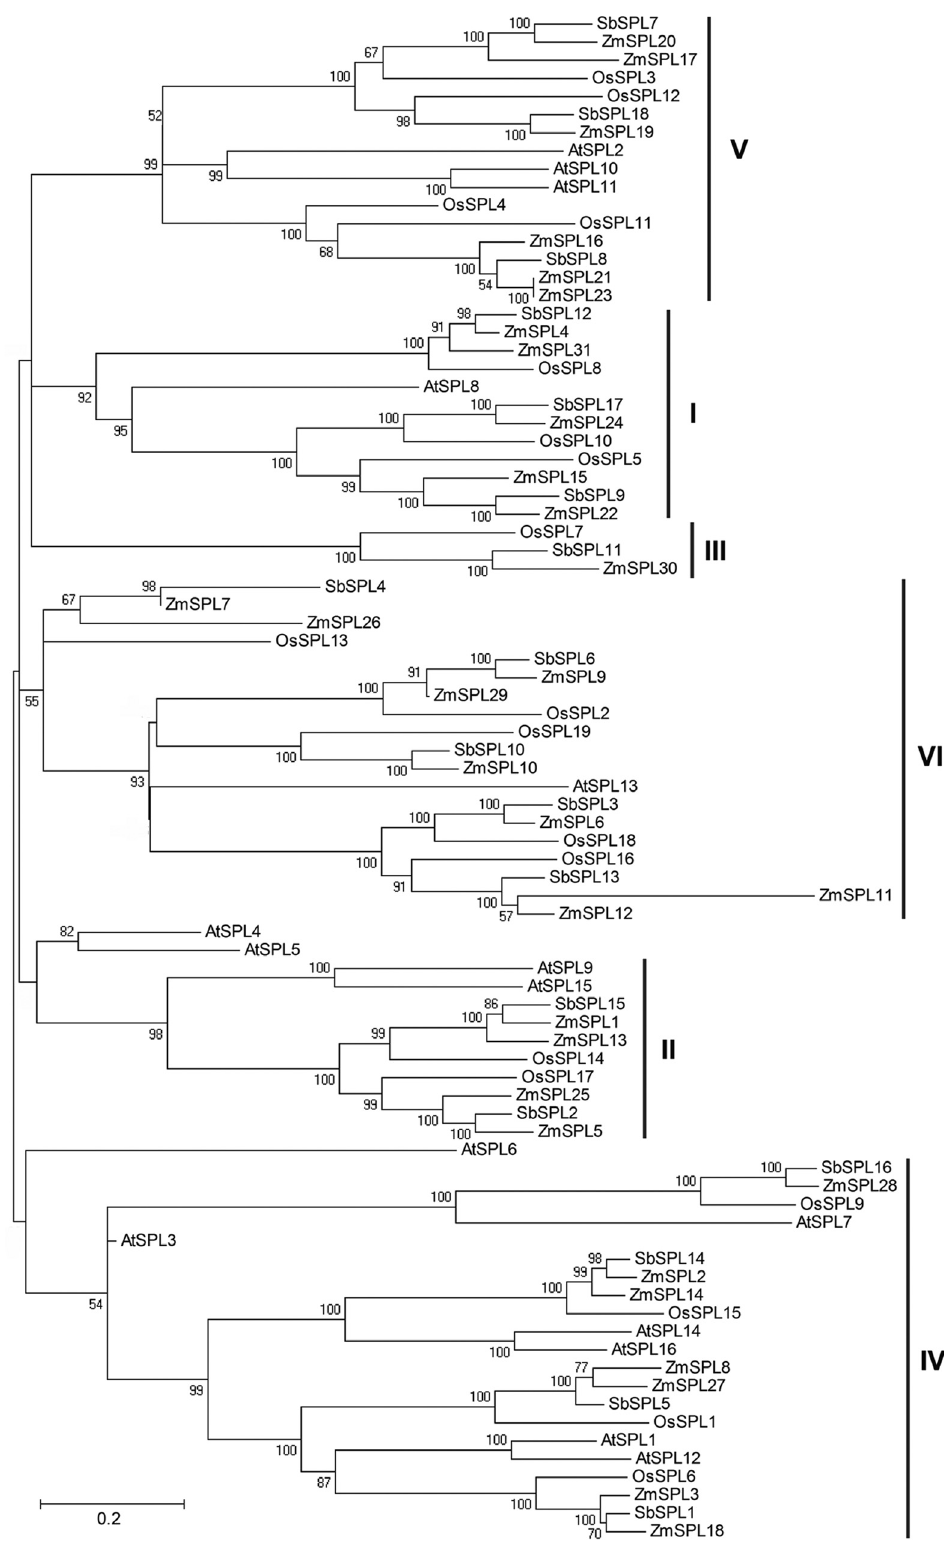
Figure 1 - Phylogenetic relationships of maize, rice, sorghum, and Arabidopsis SPL proteins. The phylogenetic tree was constructed using MEGA4.0 with the NJ method. Bootstrap values above 50% are shown at each